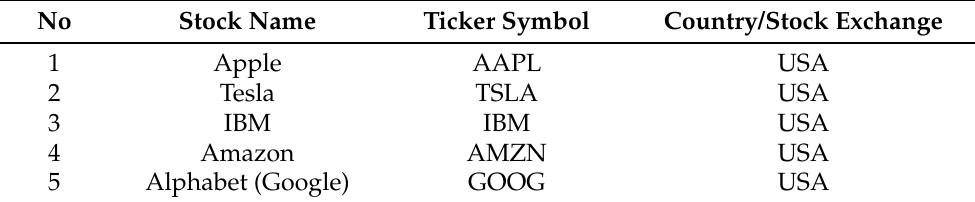
Table 1. Selected stocks’ symbols, stock name, and stock